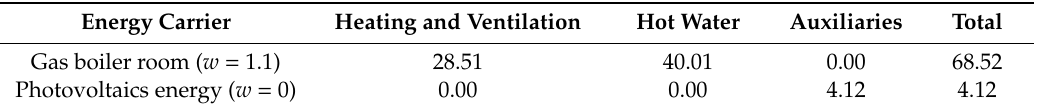
Table 11. The annual final energy demand (kWh / (m 2 · year)) for the multi-family building at Akacjowa Street in Goleniow (gas boiler room + photovoltaic system for auxiliary equipment).